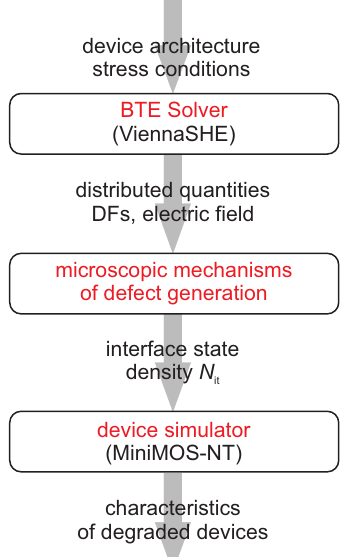
Figure 1. The schematic representation of our modeling framework which covers and links three main sub-tasks of the problem of hot-carrier degradation: modeling of carrier transport, modeling of the defect generation rates, and simulations of the degraded